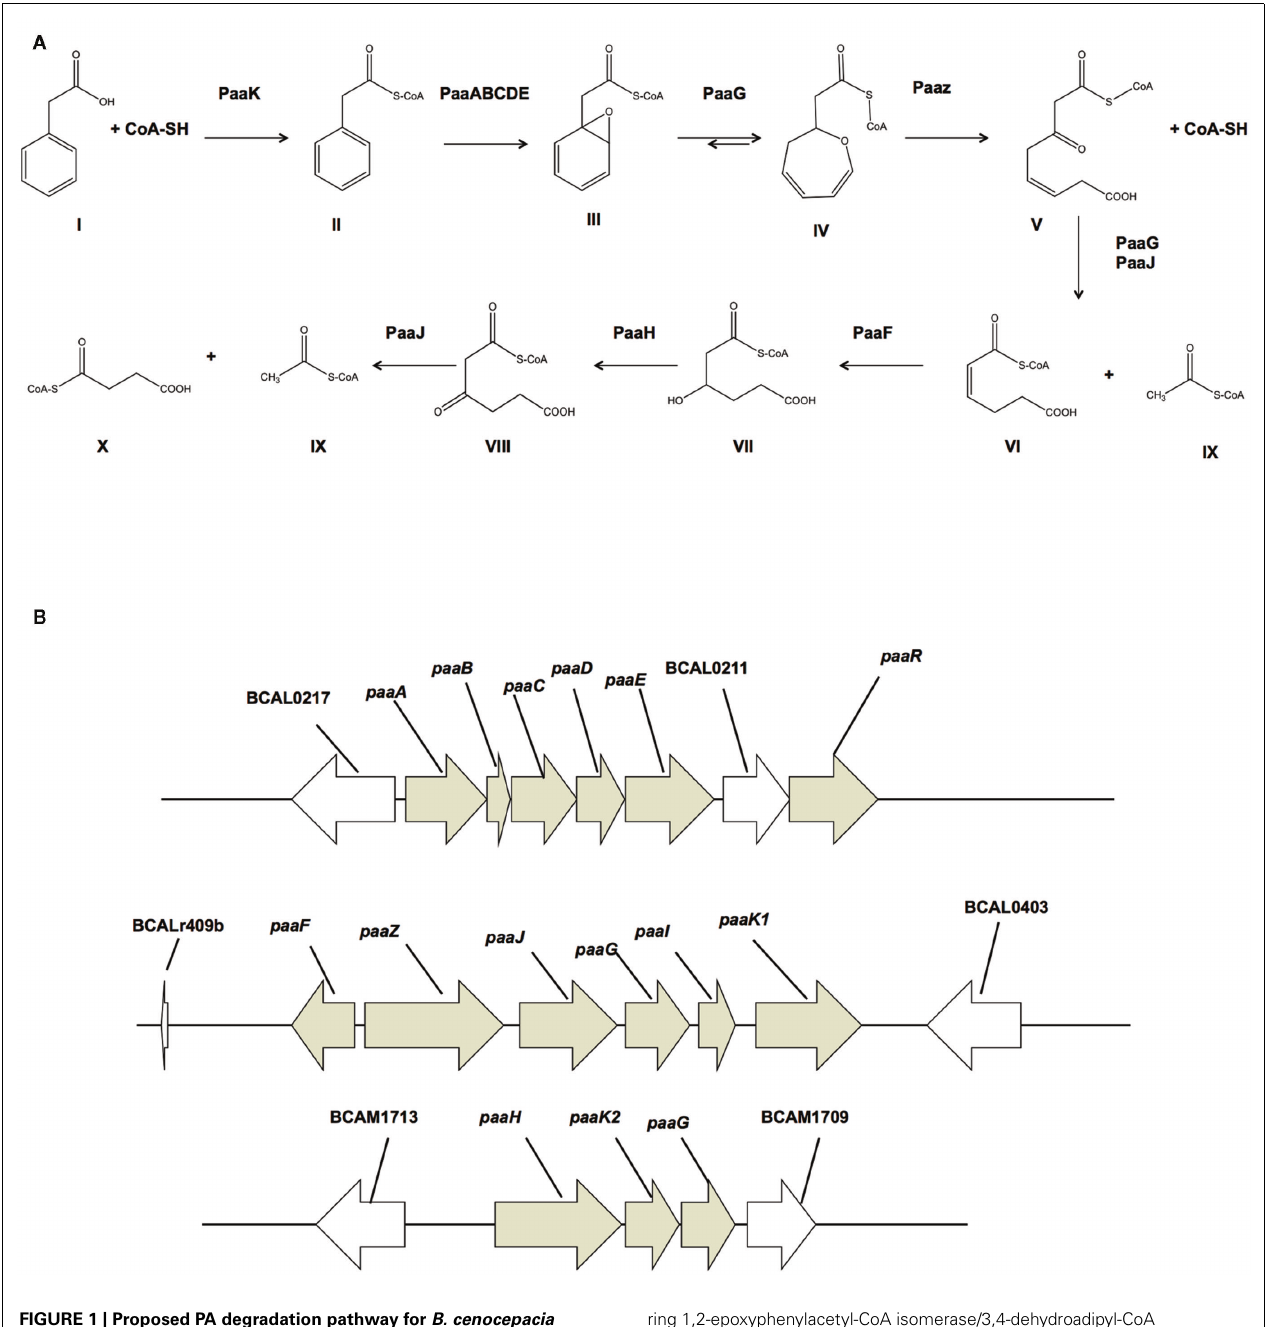
FIGURE 1 | Proposed PA degradation pathway for B. cenocepacia J2315. (A) Detailed mechanism of the PA degradation pathway for E. coli K12 and Pseudomonas putida Y2 (Teufel et al., 2010). (I) Phenylacetic acid; (II) Phenylacetyl-CoA ligase; (III) ring 1,2-epoxyphenylacetyl-CoA; (IV) 2-oxepin-2(3H)-ylideneacetyl-CoA; (V) 3-oxo-5,6-dehydrosuberyl-CoA; (VI) 2,3-dehydroadipyl-CoA; (VII) 3-hydroxyadipyl-CoA; (VIII) 3-oxoadipyl-CoA; (IX) Acetyl-CoA; (X) succinyl-CoA. Enzymes: PaaK, phenylacetyl-CoA ligase; PaaABCDE, Monooxygenase complex; PaaG,